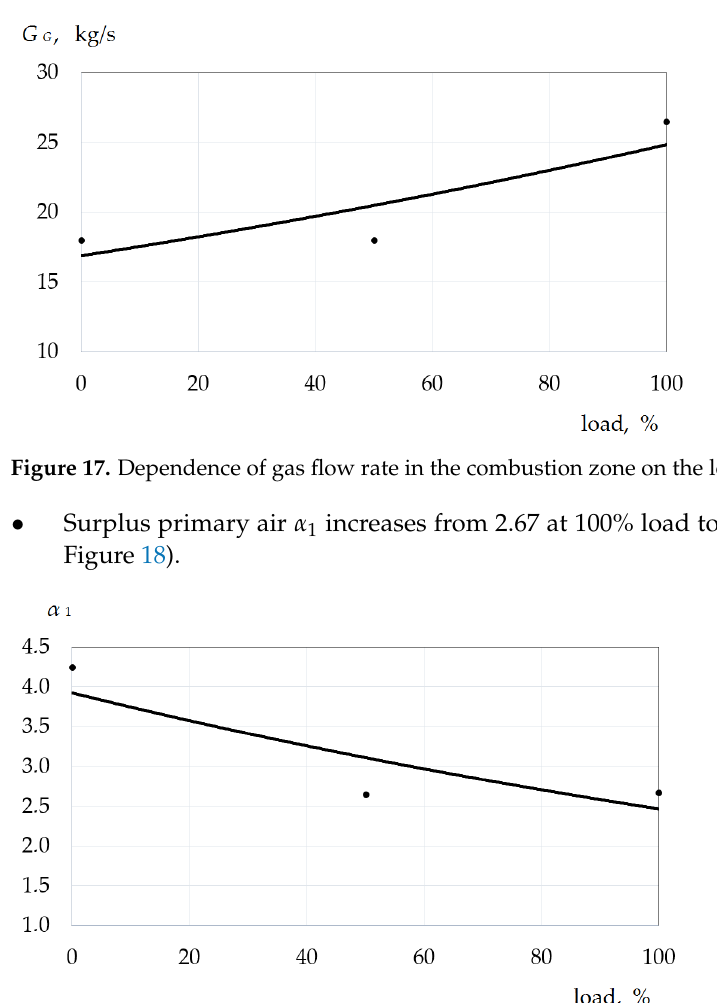
Figure 16. Dependence of air velocity in the circular duct on the load value.